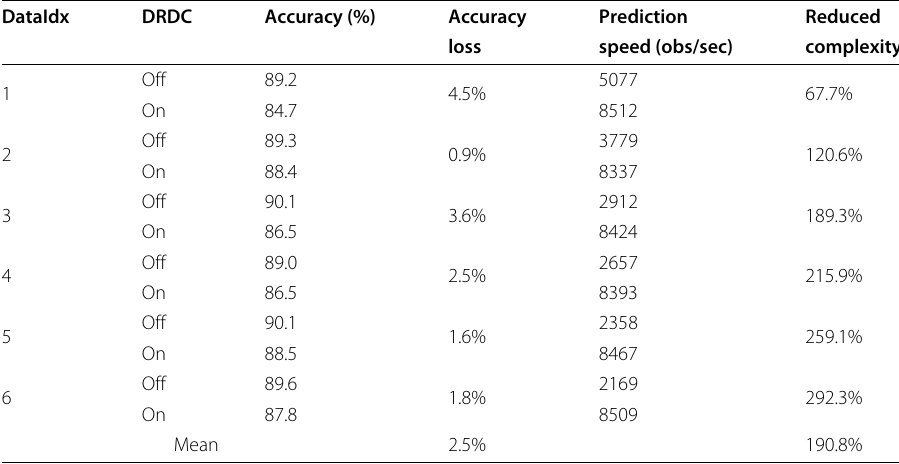
Table 8 Performance comparison between training with and without DRDC ( k new = 3, V = 2) DataIdx DRDC Accuracy (%) Accuracy Prediction Reduced loss speed (obs/sec)